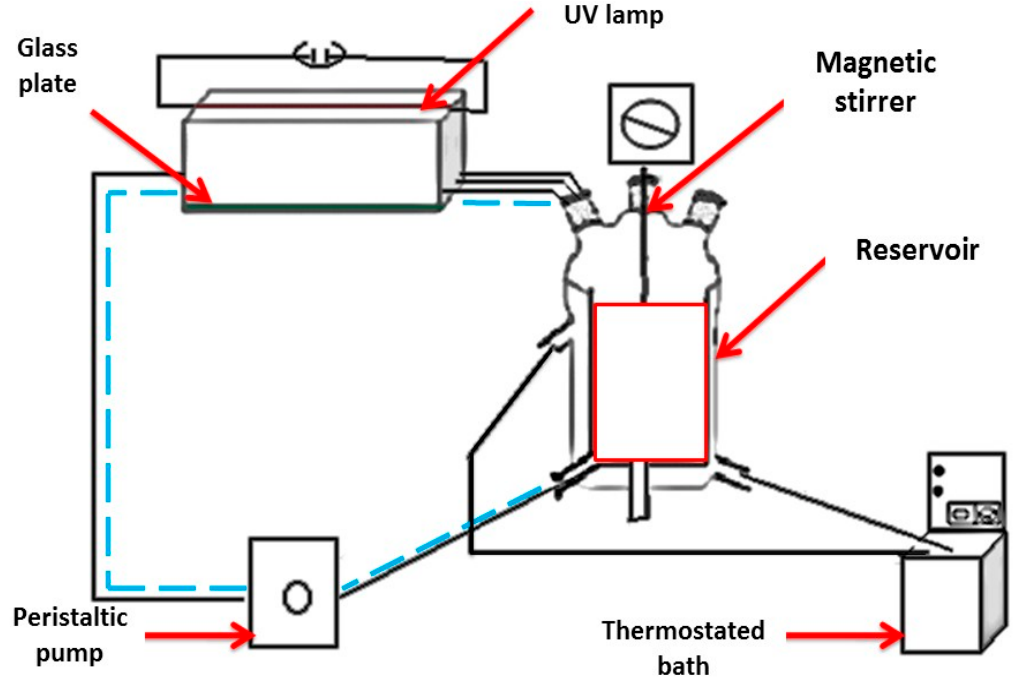
Figure 10. The experimental setup of the photocatalytic reactor.